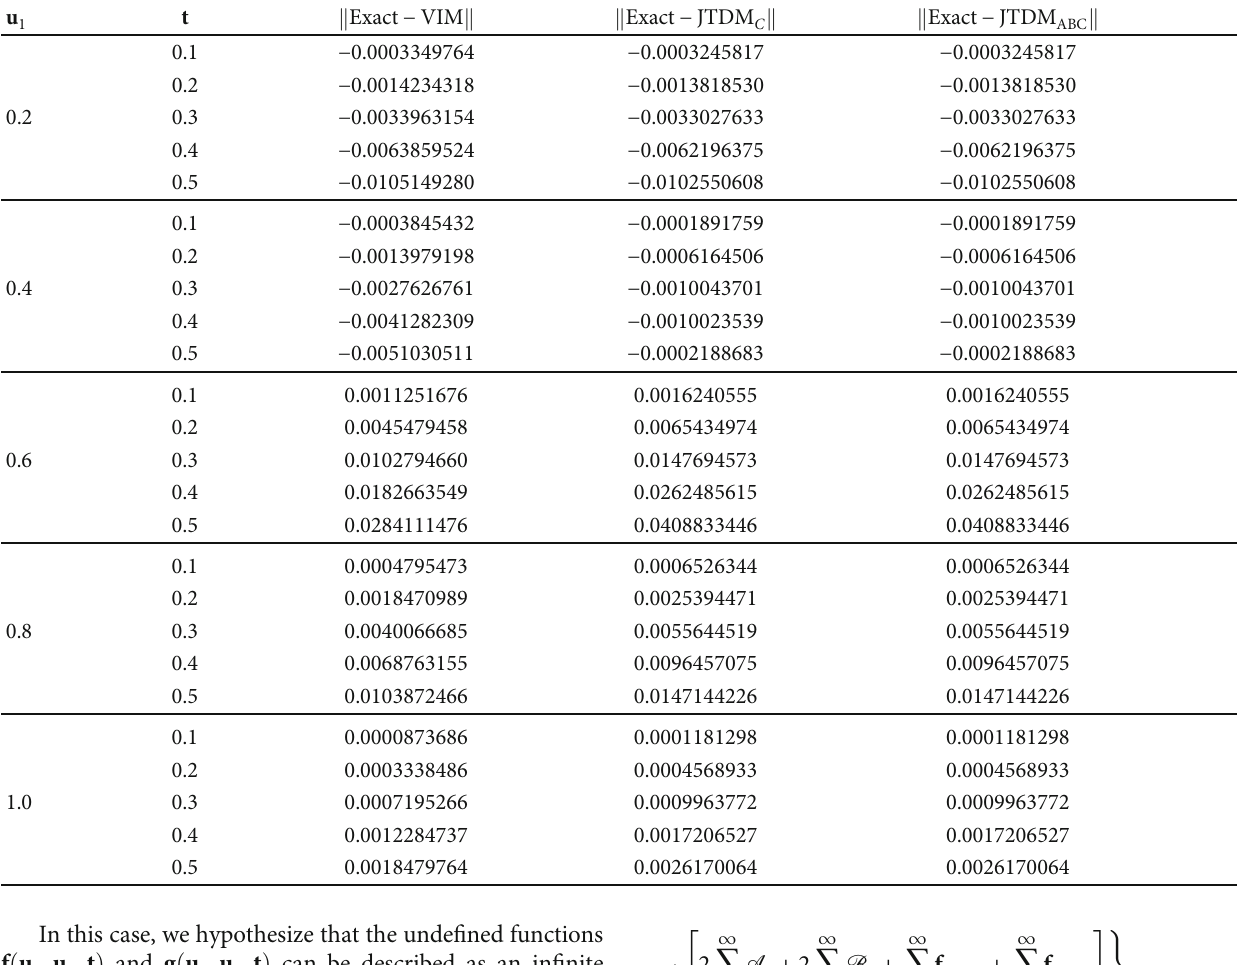
JTDM C , and ABC of Example 16 for estimated solutions of g ð u 1